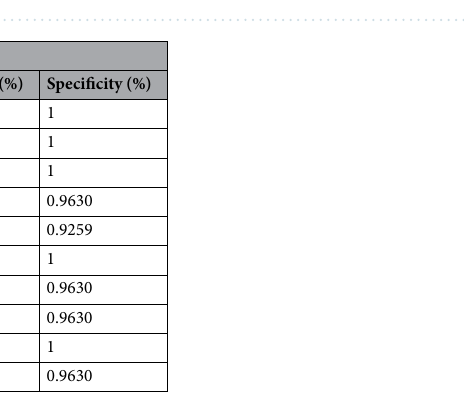
Figure 3. Spectra of tomato leaves: ( A ) Raw spectra; ( B ) FD: raw spectra after first derivative; ( C ) SD: raw spectra after second derivative; ( D ) SNV: raw spectra after standard normal variate; ( E ) MSC: raw spectra after multiplicative scatter correction.